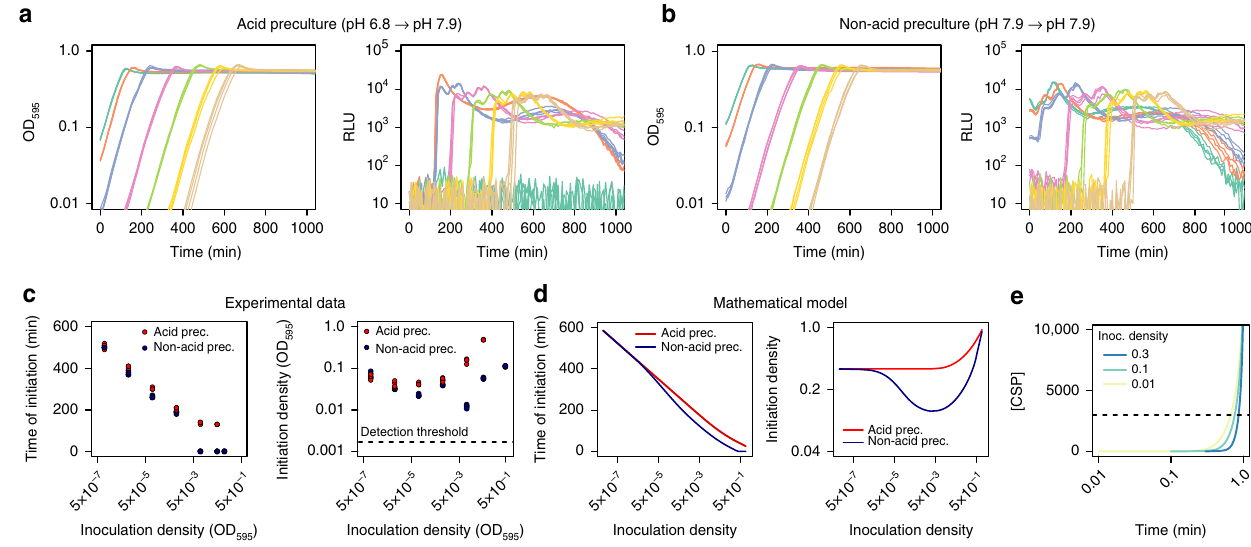
Fig. 2 Competence is regulated by cell density. a , b Growth curves (OD 595nm ) and competence expression measured as relative luminescence units (RLU) expressed from the promoter of the late competence gene ssbB for populations inoculated at a range of densities and grown in C+Y medium with initial pH 7.9. In a , cells were precultured in acid conditions (pH 6.8), while in b cells were precultured in non-acid conditions (pH 7.9). Four replicates are shown for each of seven inoculation densities (OD 595nm ): 0.1 ( green ), 0.05 ( red ), 0.01 ( blue ), 10 − 3 ( purple ), 10 − 4 ( light green ), 10 − 5 ( yellow ), and 10 − 6 ( brown ). Competence does not develop in cells coming from acid preculture and inoculated at a density of 0.1. c Effect of inoculation density on the time until competence initiation ( left panel ) and the population density at which competence was initiated ( right panel ). Competence initiation was de fi ned as the time where the RLU signal exceeded 200 units. Note that our luminometer has enough sensitivity to detect light from competent cells at a density of 1.56 ×10 − 3 or higher even if they correspond to a subpopulation (Supplementary Fig. 2). d Predictions of the mathematical model concerning the effect of inoculation density on the timing of competence initiation ( left panel ) and the density at which competence initiates ( right panel ). In the model, competence initiation was de fi ned as the time where the total concentration of ComX times the population density exceeds 2000 units. Non-acid preculture is simulated in the model by setting the initial amount of all proteins in the competence regulatory network to the value they attain when cells are competent. e The model predicts that populations inoculated at lower densities will reach a threshold CSP concentration ( dotted line ) at a lower density than populations